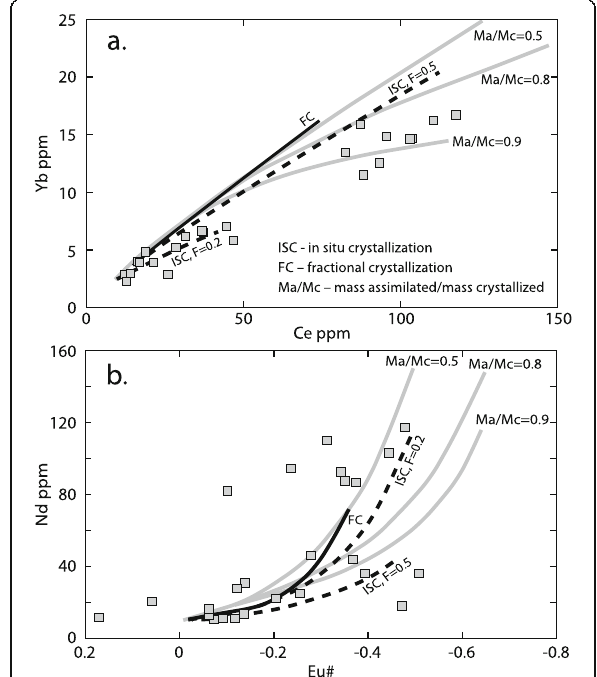
Fig. 45 Crystallization models for our samples compared to the hypothetical melts in equilibrium with the augites. a Plot of Yb vs Ce (ppm). It appears that the AFC-models and in situ fractionation fit the augite melts better than a pure fractional crystallization model. Ma, mass assimilated; Mc, mass crystallized; f, fraction of melt returned from the mush-zone to the magma chamber. b Plot of Nd (ppm) vs Eu#. Eu* = (Eu* − ([Sm* + Gd*] × 0.5) − 1), where Eu*, Sm*, and Gd* represent chondrite-normalized values. Negative Eu# values represent negative Eu anomalies, indicating fractionation of plagioclase from the